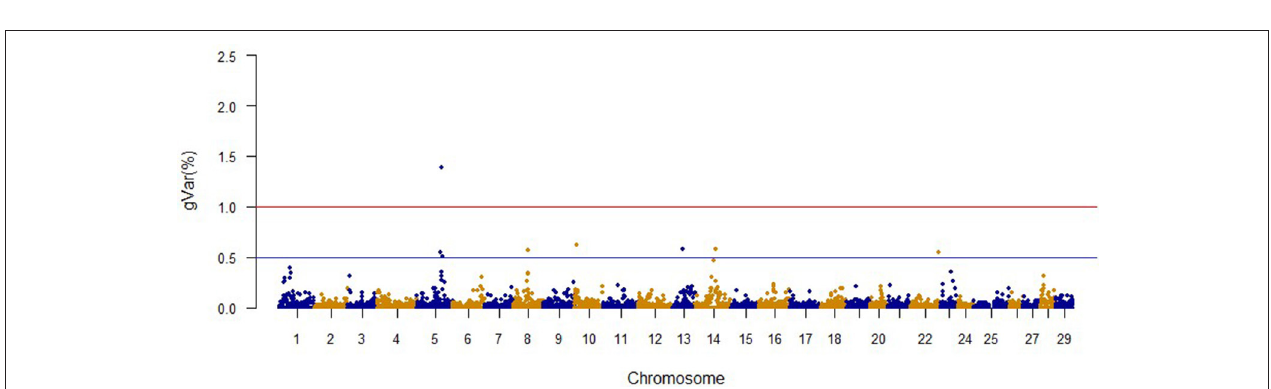
FIGURE 2 | The proportion of genetic variance explained by 20-SNP regions for fillet weight.